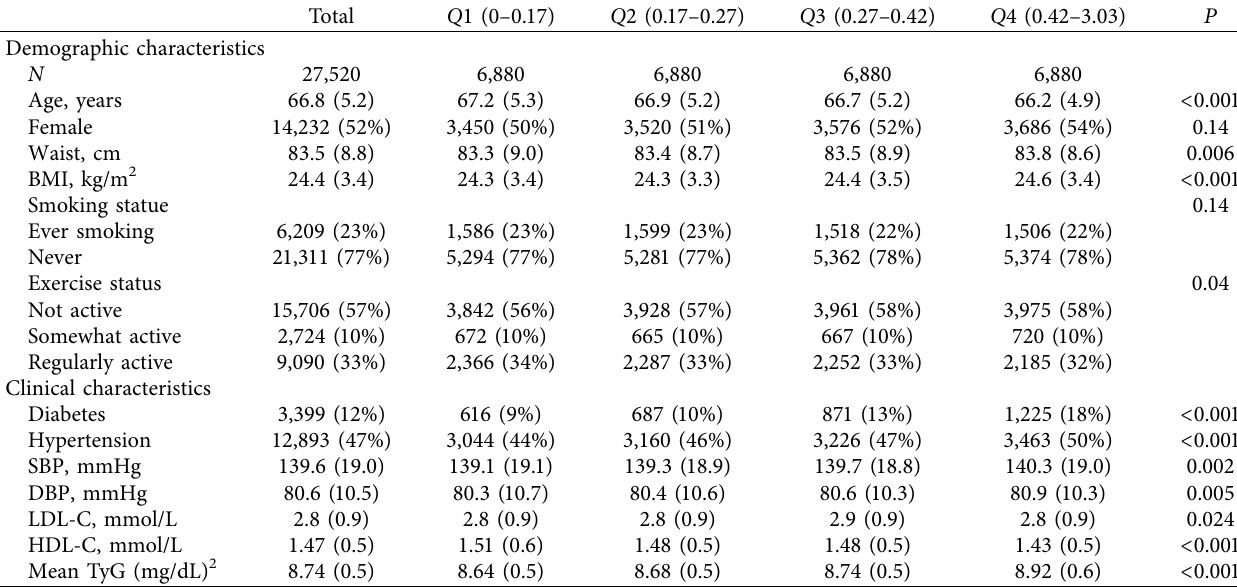
Table 1: Baseline characteristics according to the quartiles of TyG variability.